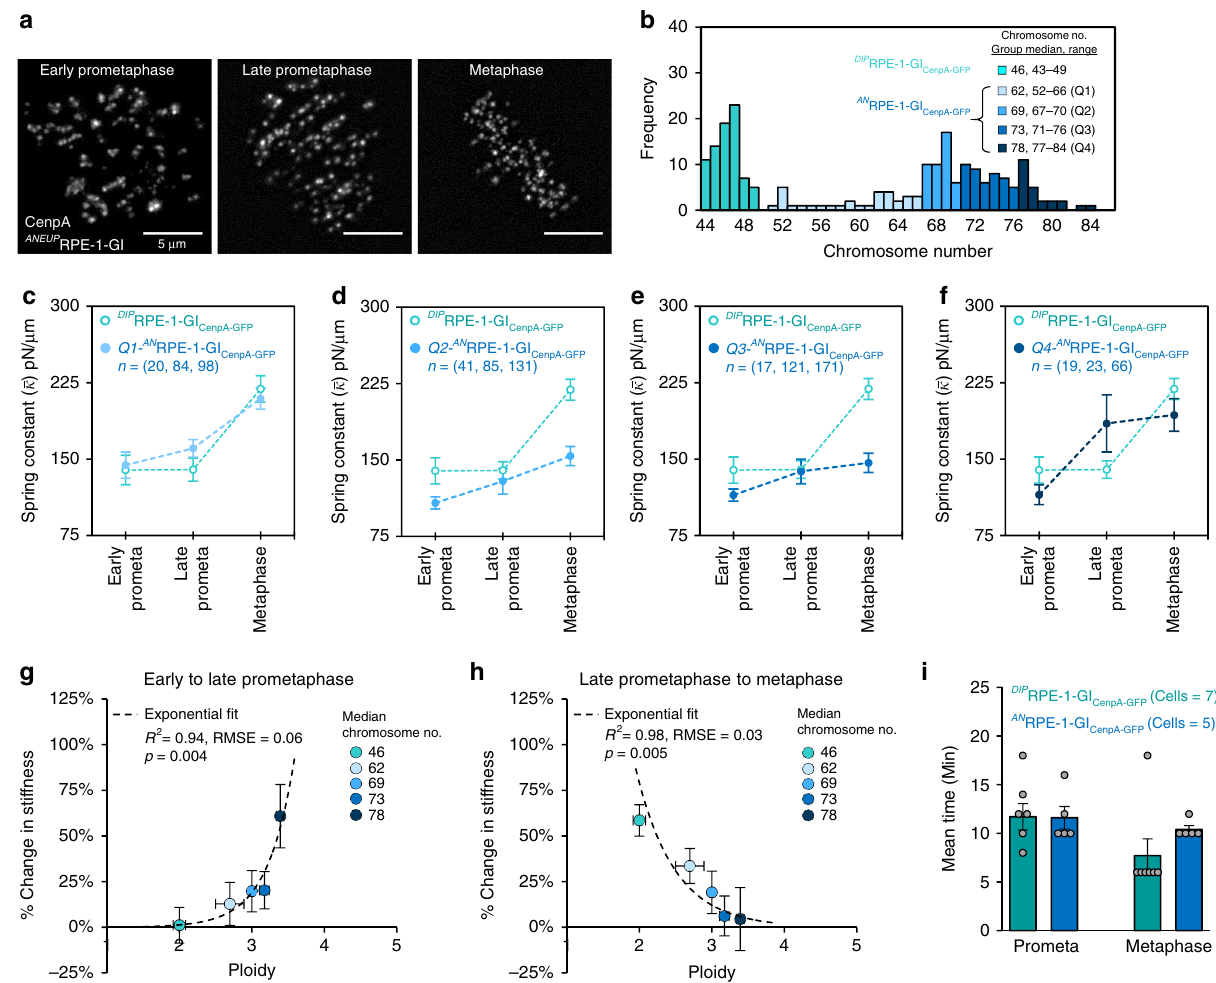
Fig. 8 Aneuploidy impairs centromere mechanical maturation. a Live cell imaging of AN RPE-1-GI cells expressing CenpA-GFP at the outer centromere. Images are maximum intensity projections from full-cell-volume image series, and are representative of the described mitotic stages: early-prometaphase (left), late-prometaphase (center), and metaphase (right). b Histogram of chromosome numbers for a sample of RPE-1-GI cells differentiating between diploid cells and aneuploid cells. AN RPE-1-GI cells are also subgrouped by quartile (Q1, light blue – Q4, dark blue ; n Ce spring constant by mitotic stage for AN RPE-1-GI chromosomes by quartile of increasing chromosome numbers as in panel b (Q1, light blue fi lled data point – Q4, dark blue fi lled data point). Data from DIP RPE-1-GI cells included for comparison (green un fi lled data points; n = 131 EP, 136 LP, 178 M, all panels). Error bars represent standard error. All n -values listed are chromosome numbers. g , h Relationship between percent change in mean stiffness from g early to late-prometaphase or h late-prometaphase to metaphase and cell ploidy for RPE-1-GI cells. Data points include DIP RPE-1-GI cells (green) and AN RPE-1-GI cells by quartile (Q1, light blue – Q4, dark blue). X -axis error bars represent IQR; Y -axis error bars represent standard error. Fit to an exponential regression model is indicated by the dashed-line and the listed R 2 , RMSE , and p -values. i Comparison of mean mitotic timing between DIP RPE-1-GI cells (teal) and AN RPE-1-GI cells (blue). Sample sizes ( n ) re fl ect the number of cells in each group. Error bars represent standard error; dots represent individual cells. See also Supplementary Figs. 5 and